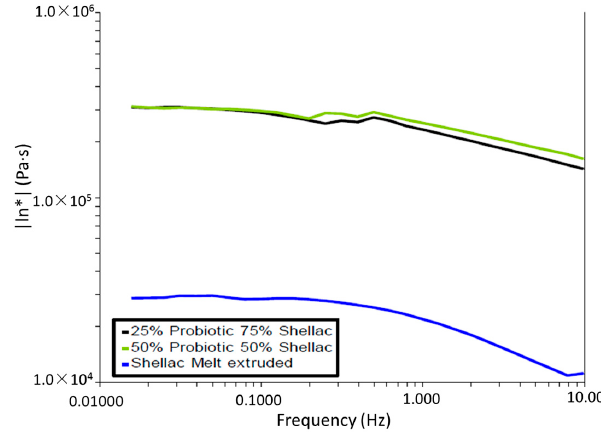
Figure 5. Complex viscosity versus frequency (Hz) curves at 70 ◦ C for SSB ® 55 shellac and Biocare ® Bifidobacterium Probiotic